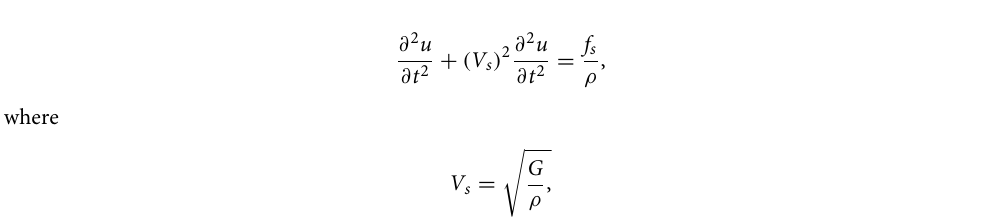
Figure 6. Mechanical configuration of micro-electro-mechanical systems (MEMS) sensor array. ( a ) Three accelerometers were attached to the above and lower sections of maize stalk and the output voltage was recorded using a PC-based data logger with high frequency. Traveling velocity of impact waves between S1 and S2, as well as S2 and S3 on stalk were measured. ( b ) Simplified schematic diagram of sensor array. ( c ) Field measurement of wave velocity using the developed system. ( d ) Pulling tassel base for bending vibration test. ( e ) Impact test using rubber